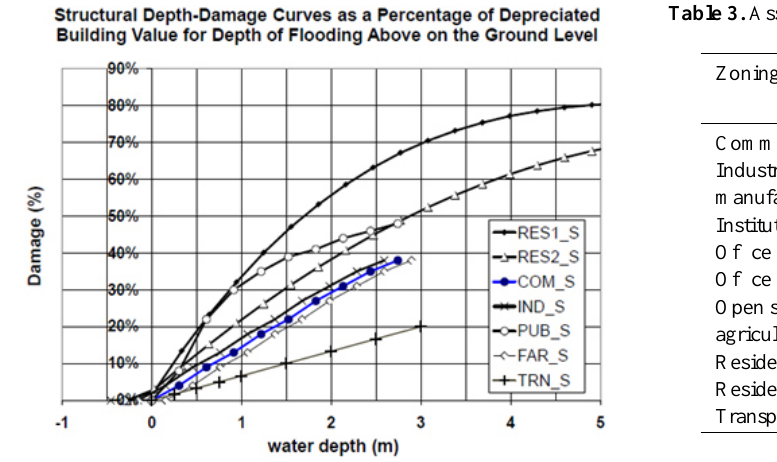
Figure 2. Structural depth–damage curves implemented in the model (source: Department of Water Resources Division of Flood Management, 2008).